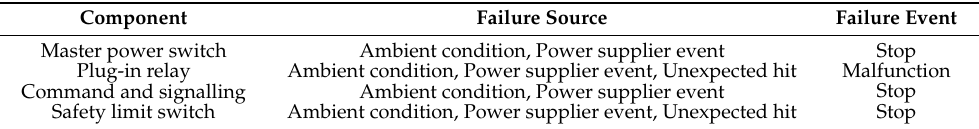
Table 1. Electrical components in the studied MSTM with failure source and